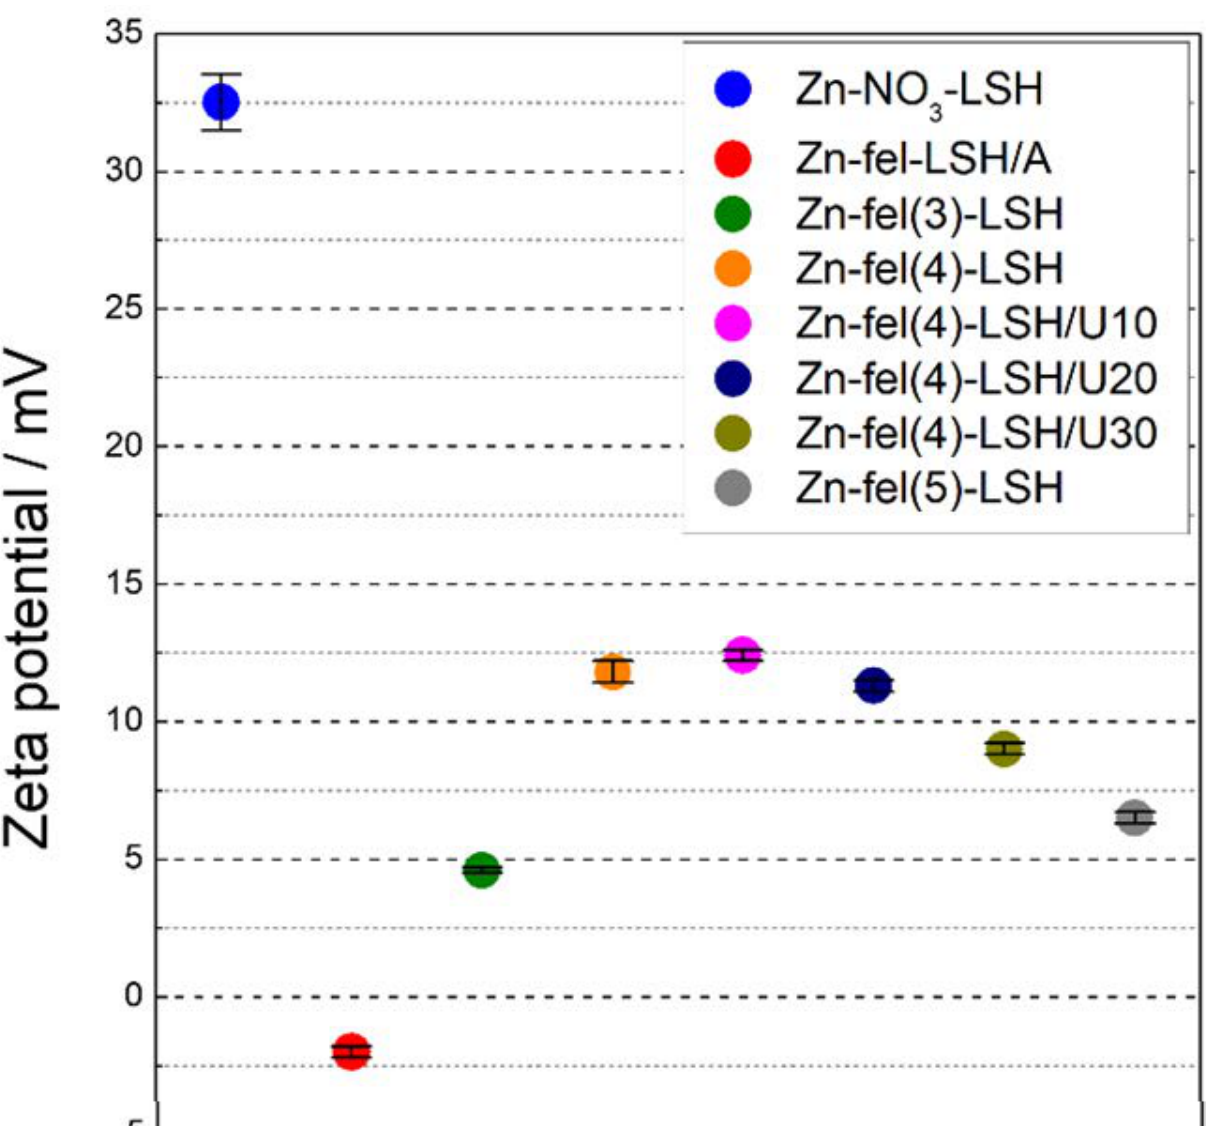
Figure 3. Zeta potential values of the Zn-NO 3 -LSH matrix and LSH-ferulate